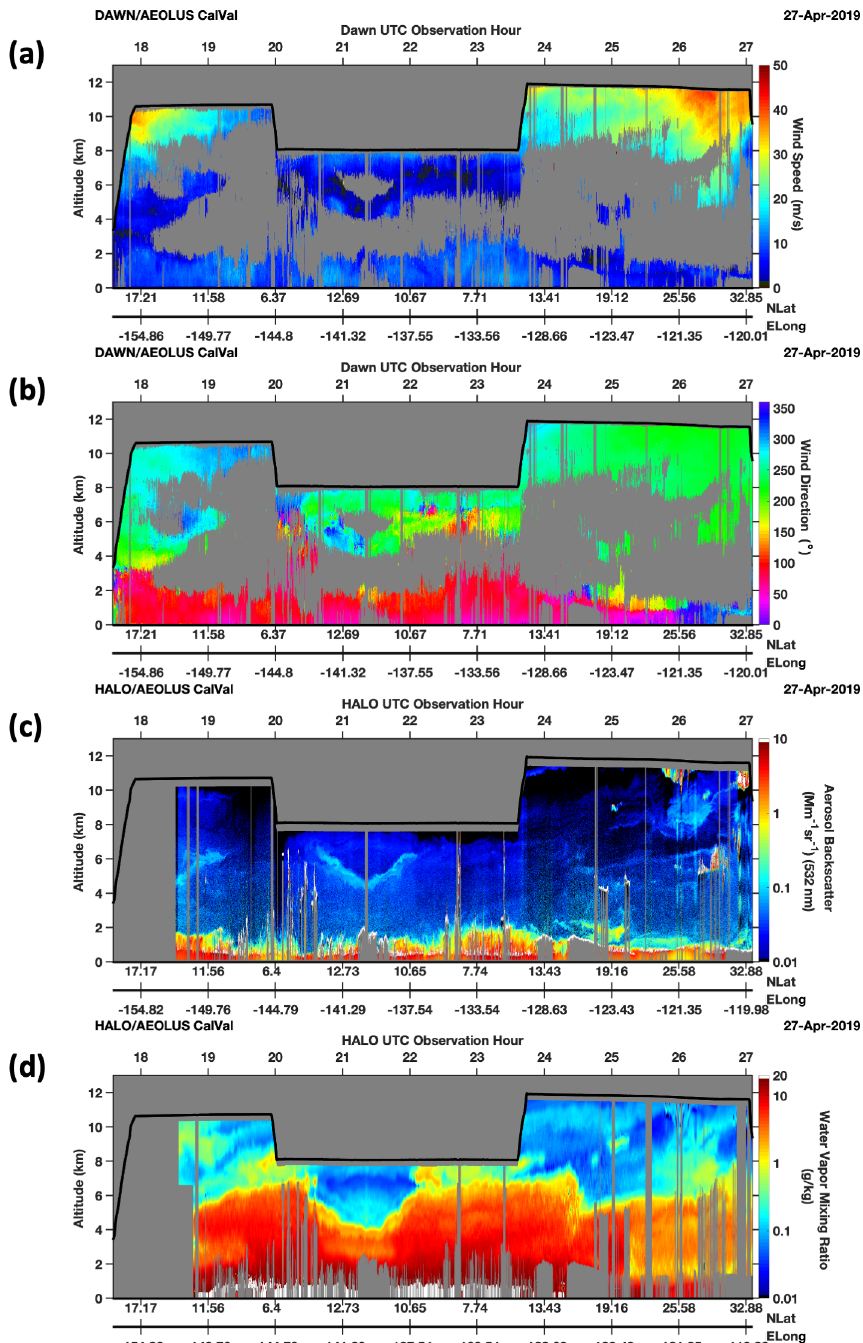
Figure 12. The same as Fig. 6 except for the 27 and 28 April 2019